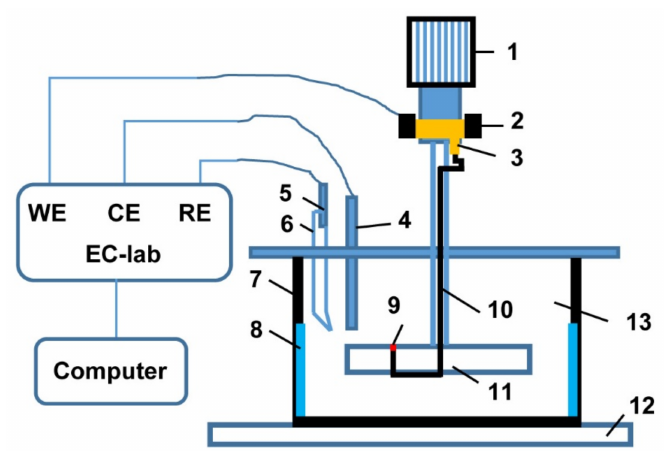
Figure 1. Metallographic structure of 1Cr5Mo steel after etching.